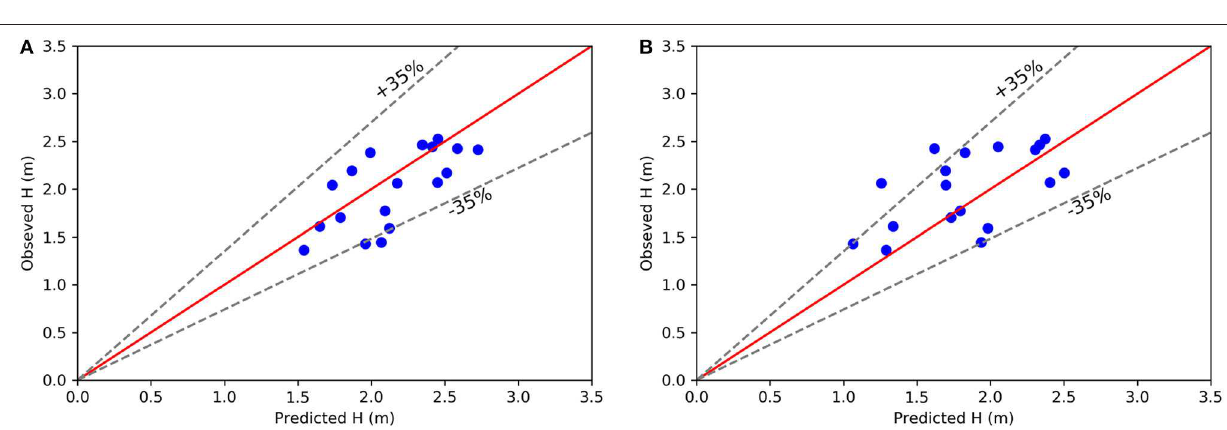
FIGURE 4 | Comparison between predicted and observed flame height values using (A) two-fifths power law and ˙ Q max obtained from ˙ m max [method 1 of Sun et al. (2006) ] (B) two-fifths power law and ˙ Q max obtained from ˙ m